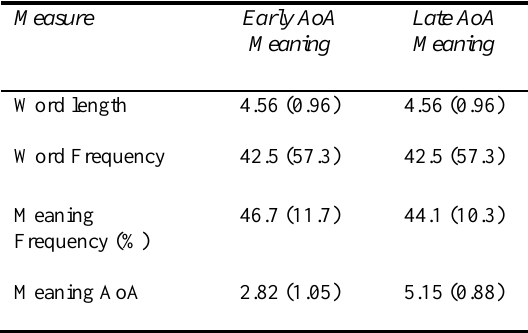
Stimuli Characteristics .